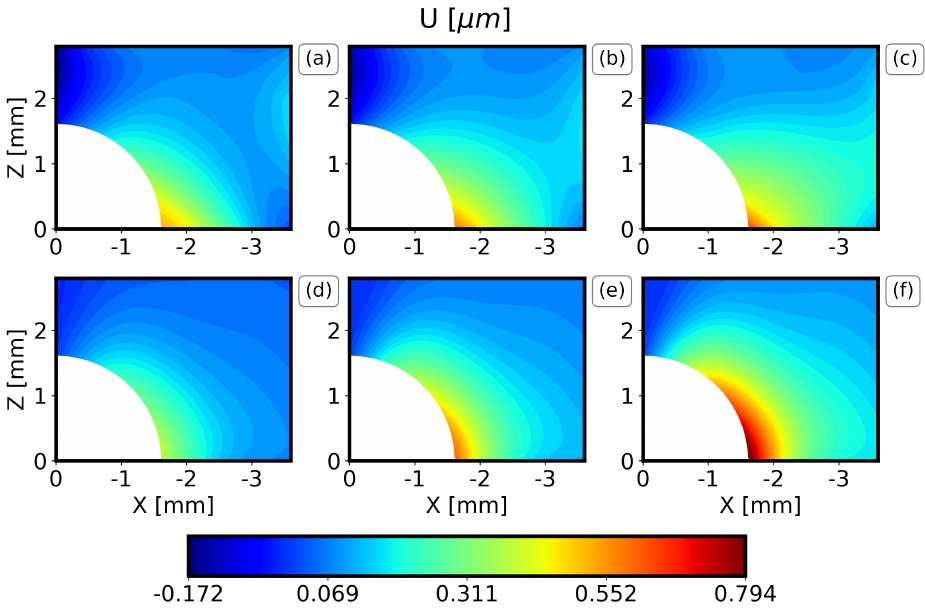
Figure 8. Comparison of DIC measurements and PC results for the U − displacement field and a drilling depth 1.2 mm. ( a ) Expected experimental value minus one standard deviation, ( b ) expected experimental value, ( c ) expected experimental value plus one standard deviation, ( d ) expected PC value minus one standard deviation, ( e ) expected PC value, ( f ) expected PC value plus one standard